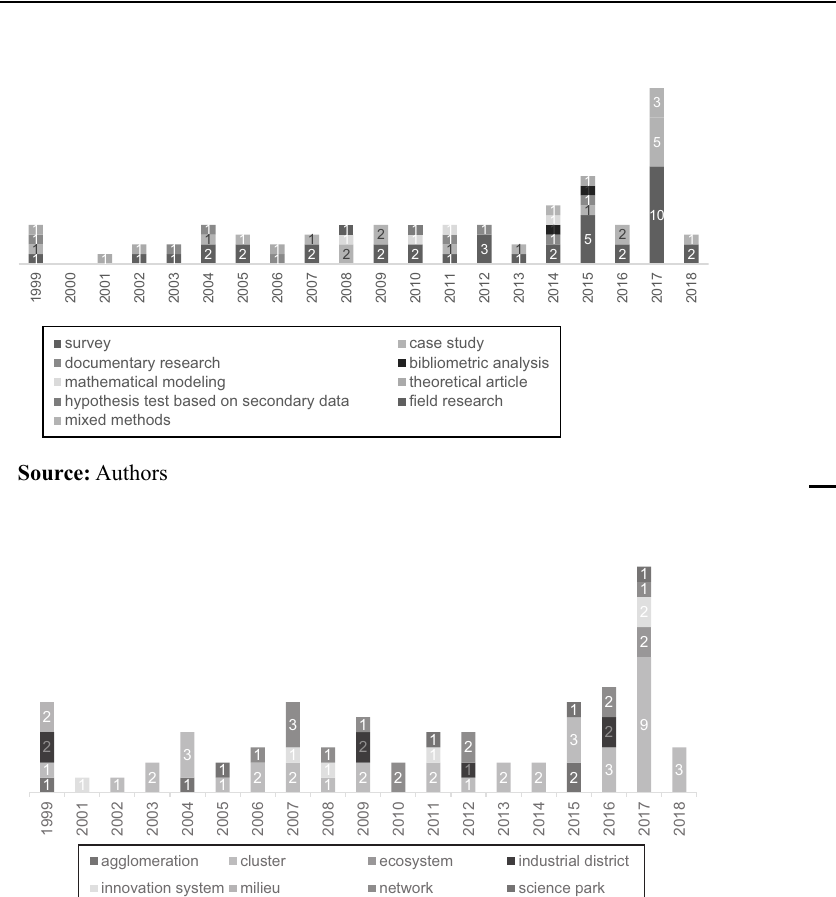
Table 2. Scienti fi c methods